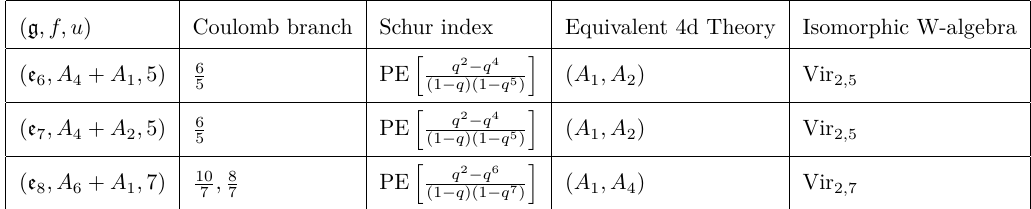
( g , f ) . The second and the third u